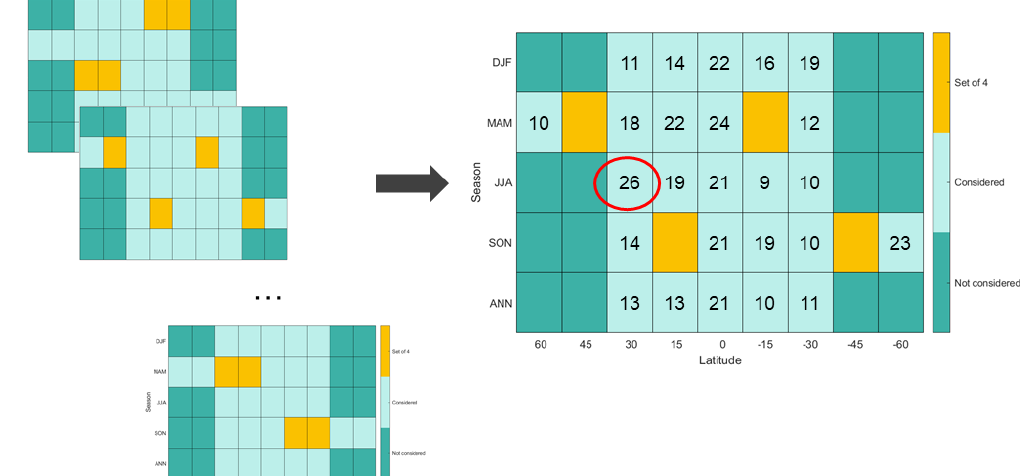
Figure 5. A schematic diagram showing how to find the smallest maximum angle θ ∗ (4) for a set of four injection choices. We first look through all possible combinations of four injection choices and calculate the maximum angle θ max , and then identify which set has the smallest value of θ max . The “best” set of four includes spring injections at 45 ◦ N and 45 ◦ S and autumn injections at 15 ◦ N and 15 ◦ S. The maximum angle for this “best” set of 4 is 26 ◦ (highlighted by a red circle), formed between this set and summer injection at 30 ◦ N; this is much smaller than 46 ◦ , the maximum angle found in the example in Fig. 4.